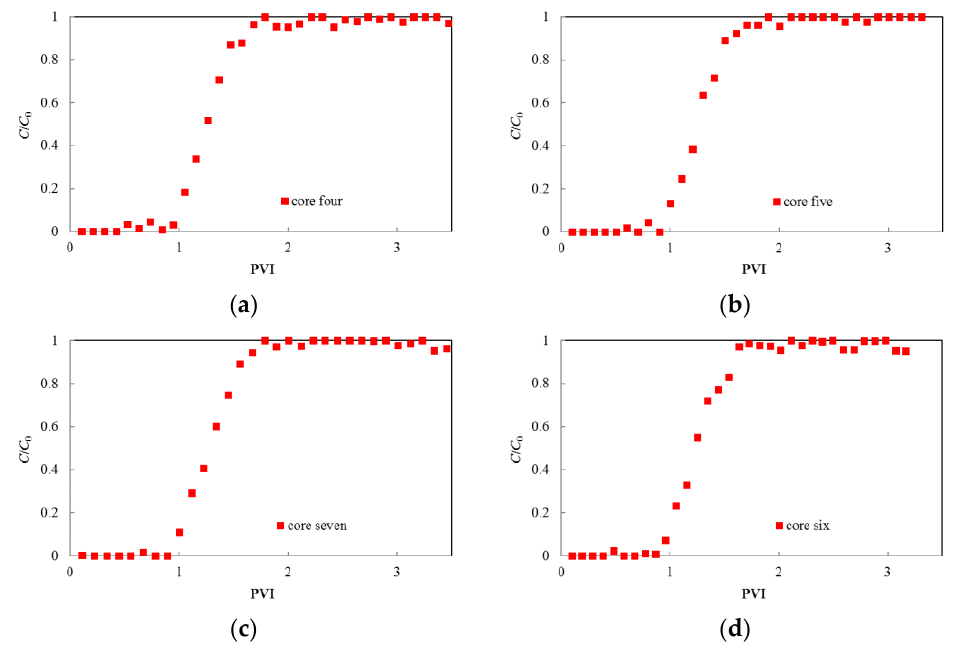
Figure 3. Tracer concentration ratio versus pore volume injected (PVI) at different flow rates in the sand-filled cores: ( a ) 0.02 cm 3 /s; ( b ) 0.03 cm 3 /s, ( c ) 0.05 cm 3 /s, and ( d ) 0.08 cm 3